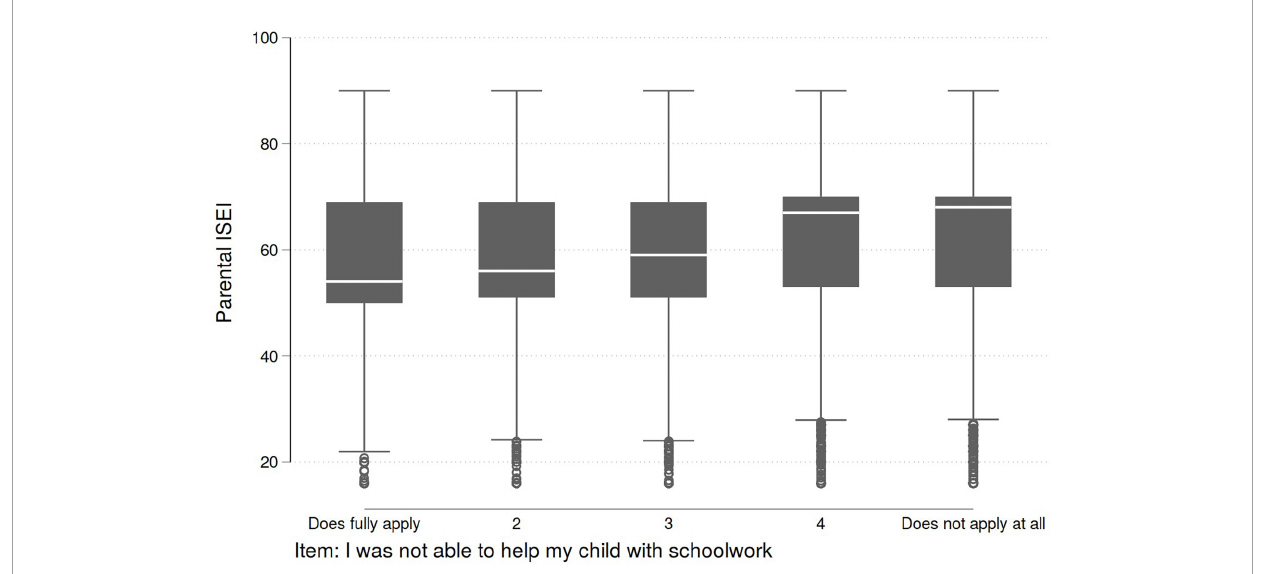
FIGURE2 Ability to help by family SES (ISEI). Data: NEPS SC2 (doi: 10.5157/NEPS:SC2:9.0.0). Own illustration; imputed data m = 100. Higher numerical values on the x -axis indicate a greater ability to help children with schoolwork. The white circles indicate the